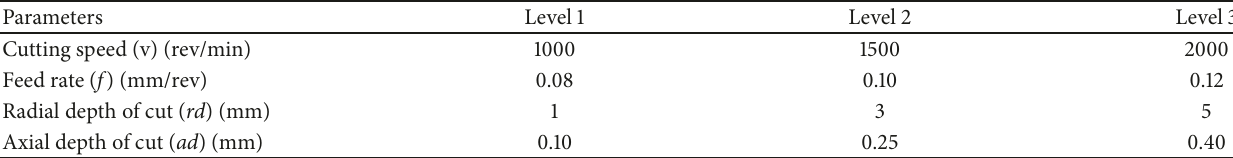
Table 2: Input parameters and their levels for milling of TC18 titanium alloy.